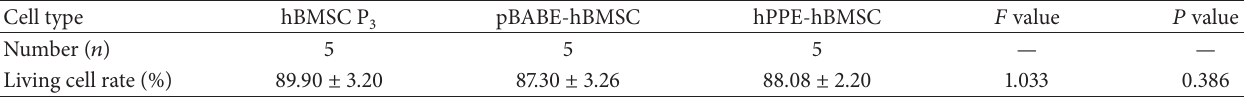
Table 2: Cell activity after freezing and recovering (%, 𝑋 ±